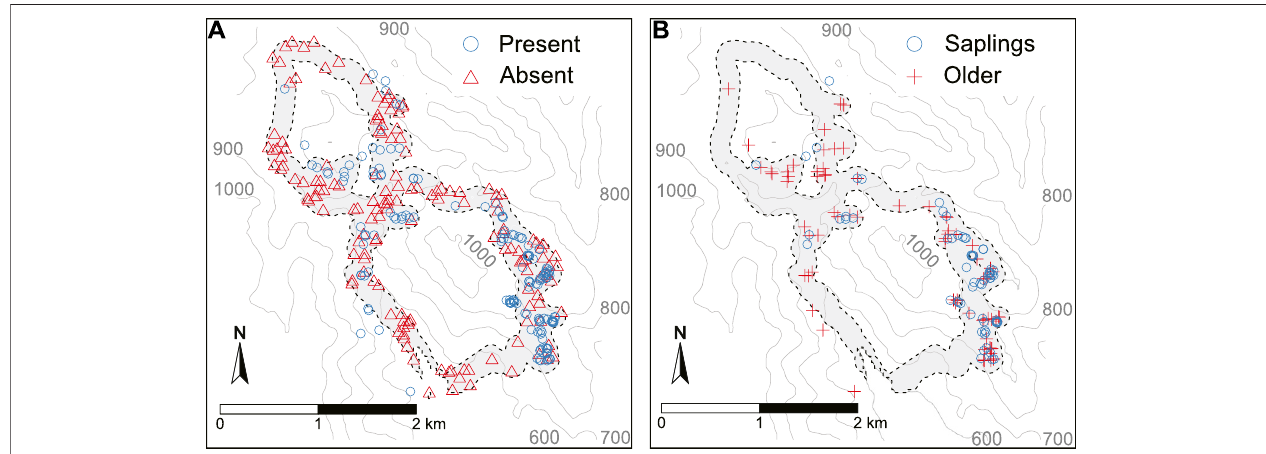
FIGURE2|(A) Present(bluecircles)andAbsent(redtriangles)Tombatobservationpoints. (B) Saplings(bluecircles)andOlder(redcrosses)Tombatobservations. Both datasets are seen in relation to buffered transects (grey polygon) and the topography in the study area. Some secondary observations are outside the buffered transects. Height contours are derived from